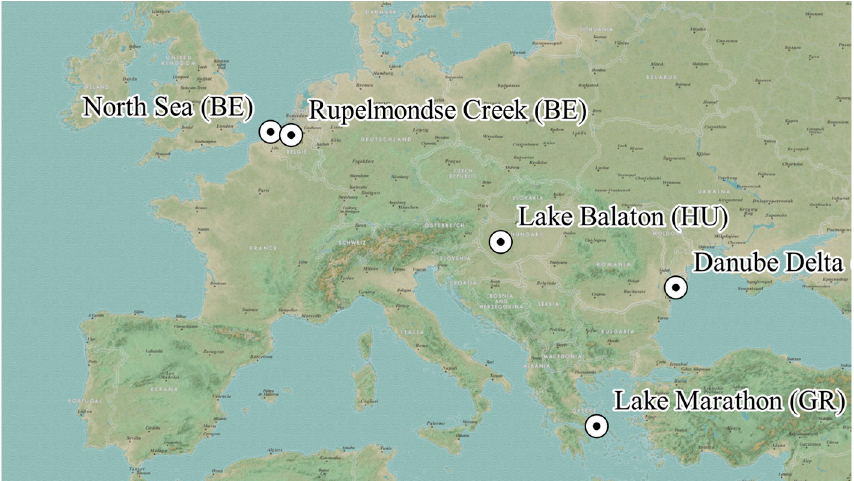
Figure 1. Drone flights performed across Europe for which simultaneous in situ data were